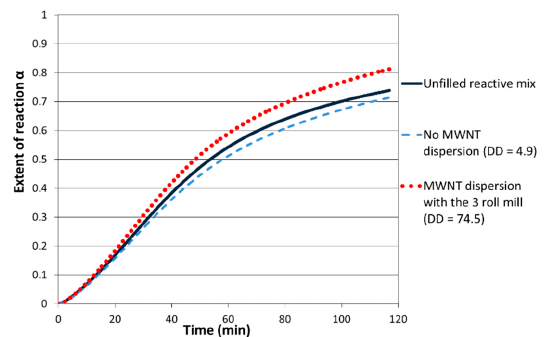
Figure 6. Extent of reaction ( α ) vs. time for a DGEBA DDS reactive system: without MWNT (continuous line) and filled with MWNT (0.7% in weight) with a different dispersion state (slashed line for the poor dispersion state and dotted line for the good dispersion state) at 150 °C.